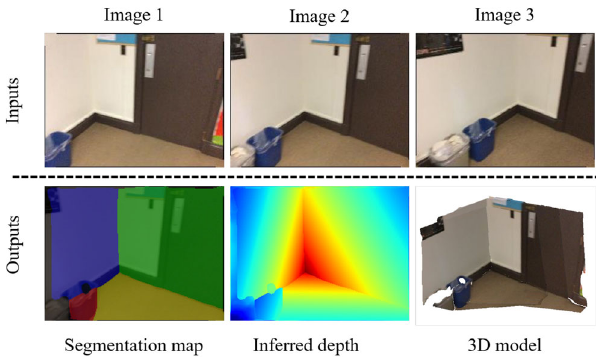
Given multiple images under different viewpoints, we reconstruct the scene by recovering plane segments and the depth map under the planar shape constraint for each image. Based on our multi-view regularization, the recovered planes and depths are more consistent and can be composed to reconstruct the scene more